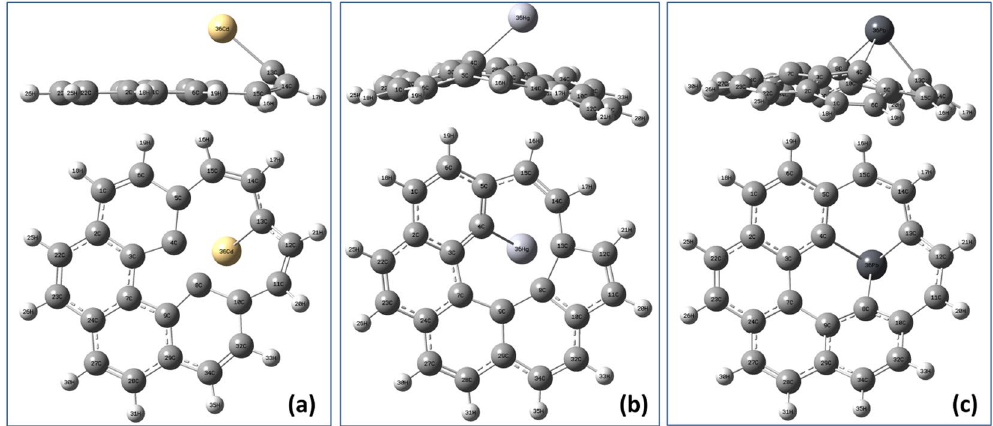
Figure 10. Optimized structure of a C 23 H 12 graphene quantum dot with a substitutional ( a ) Cd, ( b ) Hg and ( c ) Pb defect.